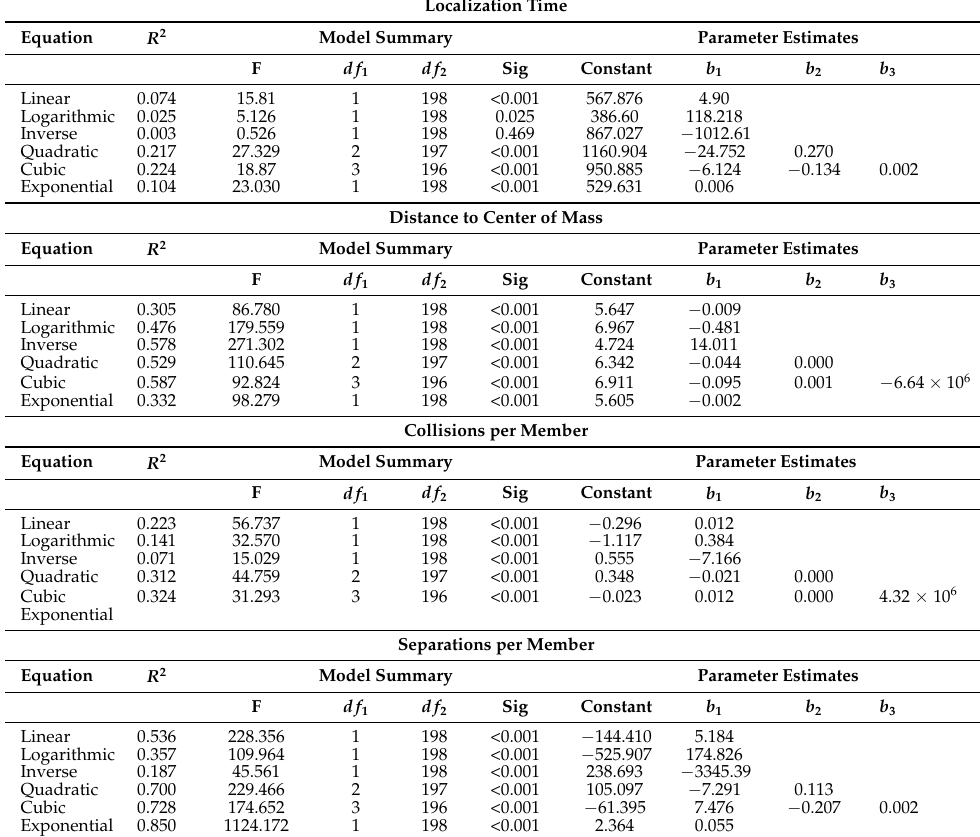
Table A6. Model summary and parameter estimates for the curve fitting obtained in experiments with obstacles for each of the nine flocking performance measures, showing five equations (linear, inverse, logarithmic, quadratic, cubic, and exponential) where the independent variable is the flock size and the dependent variable is each performance measure,